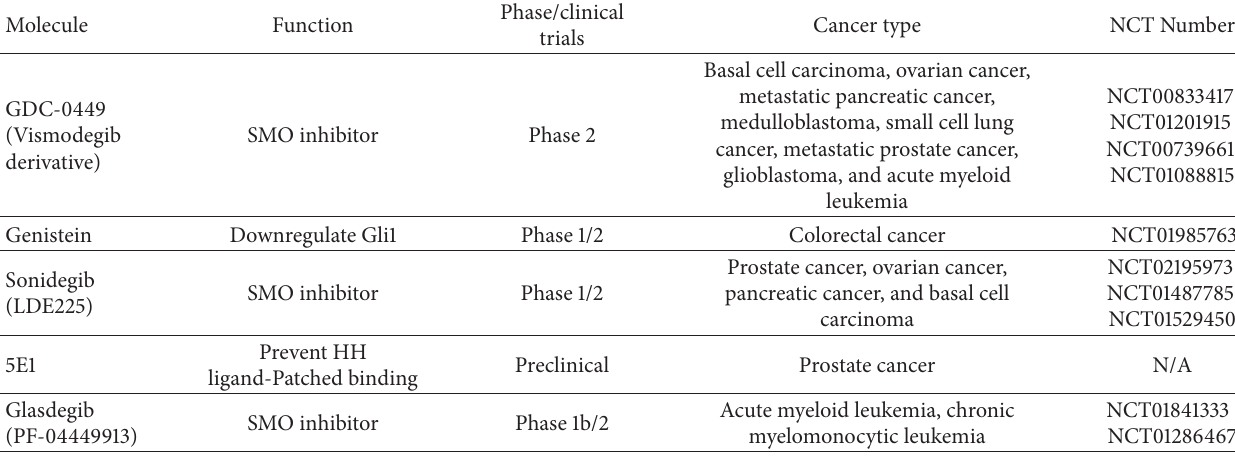
Table 2: Small molecule/biological therapeutics targeting the Hedgehog